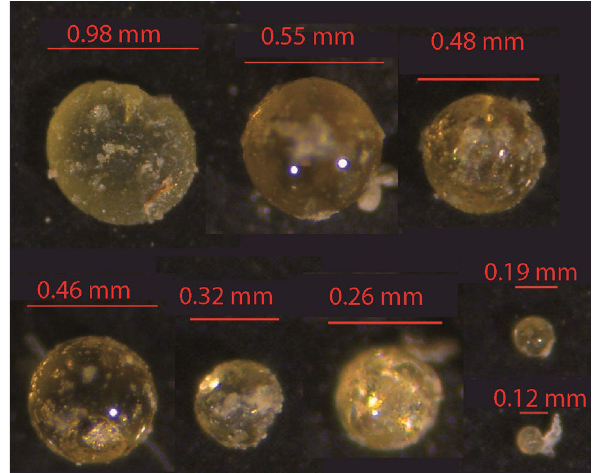
Figure 1. Examples of microtektite fragments found in the Indian Ocean core MD90-0961.